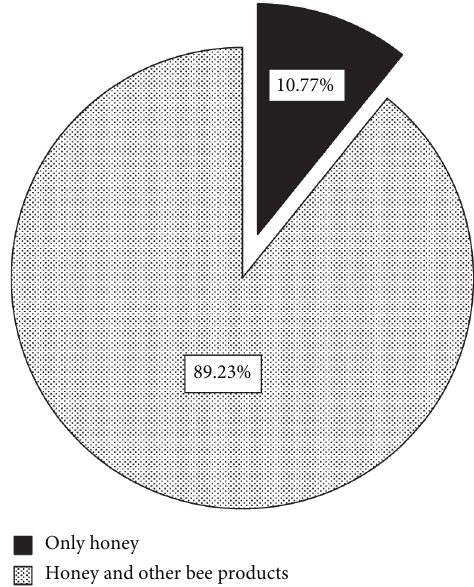
Figure 4: Percentages of honey and others bee hive